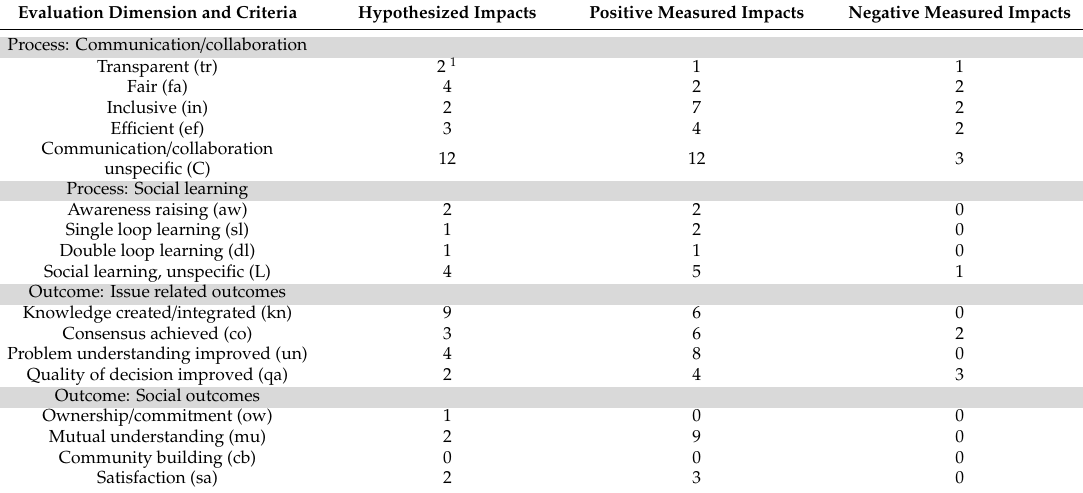
Table 4. Hypothesised and measured impacts on participation in the reviewed studies (N =